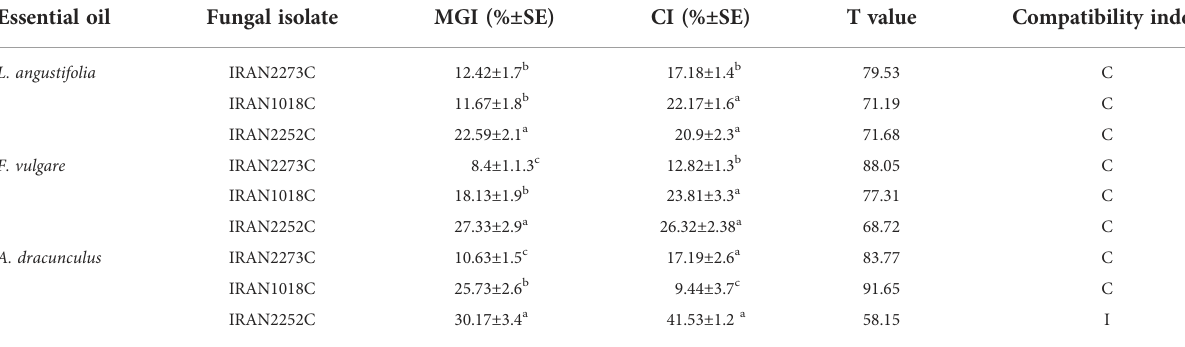
TABLE 3 Classi fi cation of L. angustifolia , F. vulgare , and A. dracunculus essential oils based on T values on IRAN2273C, IRAN1018C, and IRAN2252C isolates of M. anisopliae . Essential oil